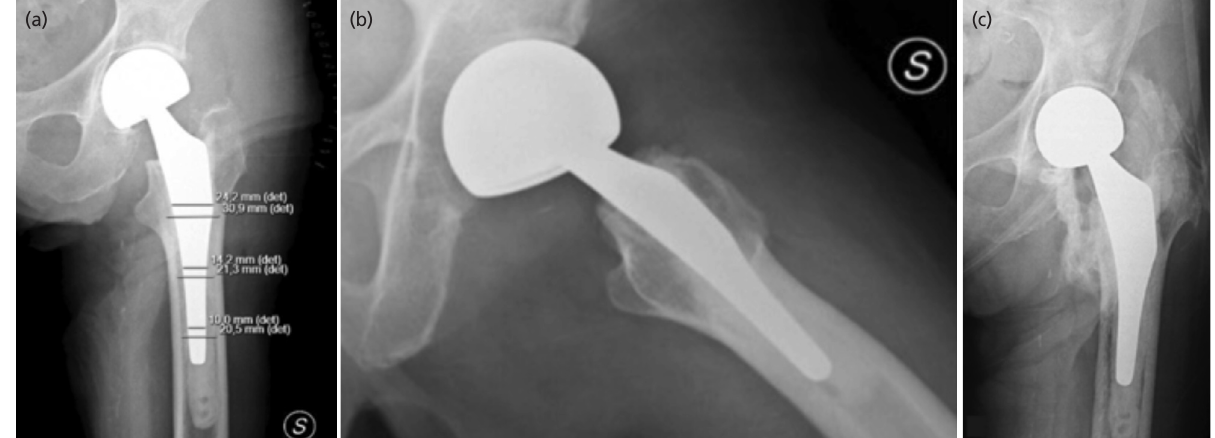
Fig. 1: (a) Anteroposterior radiography after hip-hemiarthroplasty through the lateral approach. Example of Canal Fill Index calculation. (b) Post-operative lateral view. (c) Example of heterotopic ossification (Grade 4, second Brooker Classification) 12 months after surgery.